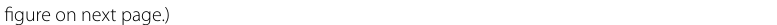
figure on next Fig. 1 Effect of polyethylene glycol (PEG) molecular weight (MW, 6000 and 8000 g mol − 1 ) and tie‑line length (TLL, 23–43% w/w) on hyaluronic acid (HA) recovery in the bottom phase of PEG–citrate aqueous two‑phase systems (ATPS). Two pure HA solutions of different molecular weights: 1–2 MDa (HA1.5) and 3–4 MDa (HA3.5) were evaluated. HA solutions were loaded to the ATPS at a final concentration of 10% (w/w). ATPS volume ratio (V R ) was 1.0. Bars represent the sample mean SEM of experimental triplicates. Bars within the same graph that do not share the same uppercase ± letter are significantly different (p <